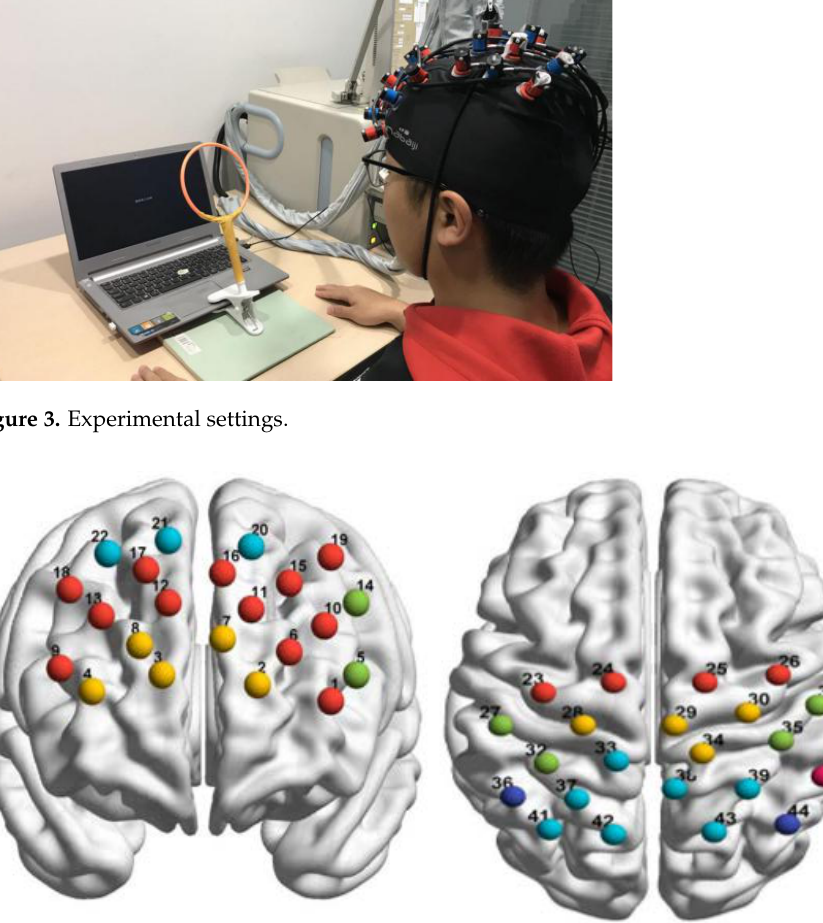
Figure 3. Experimental settings.